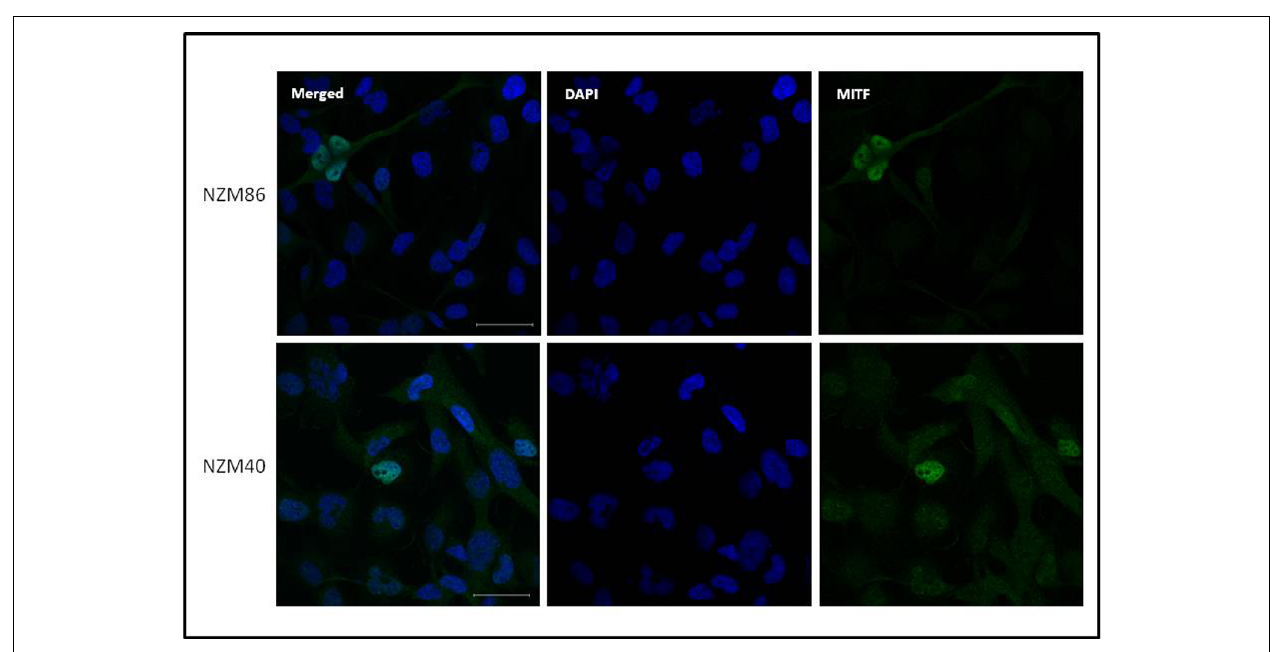
FIGURE 5 | Immunofluorescent images of NZM40 and NZM86 stained for MITF (green) and for DNA (diaminophenylindole: blue). Scale bars on the merged image indicate 50 μ m.